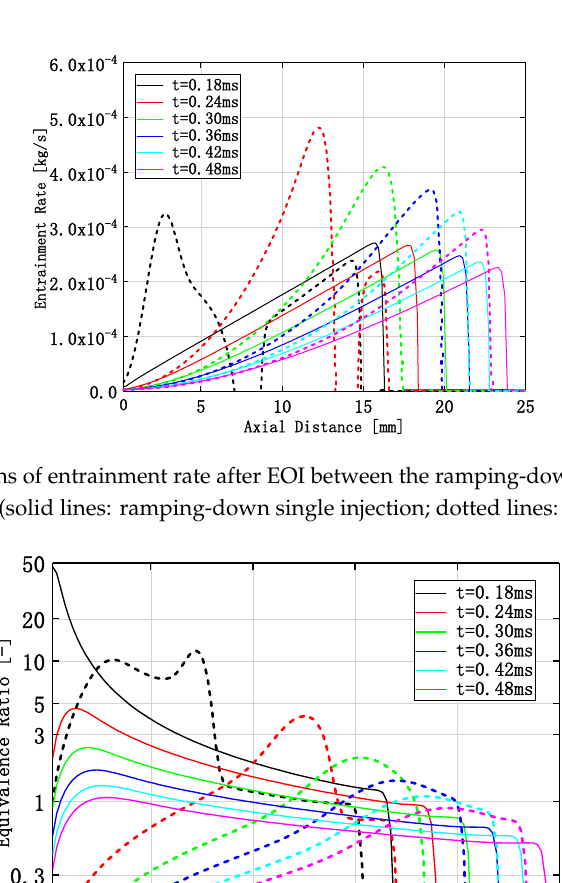
Figure 12. Schematic diagram of the ramping-down injection with gas-jet